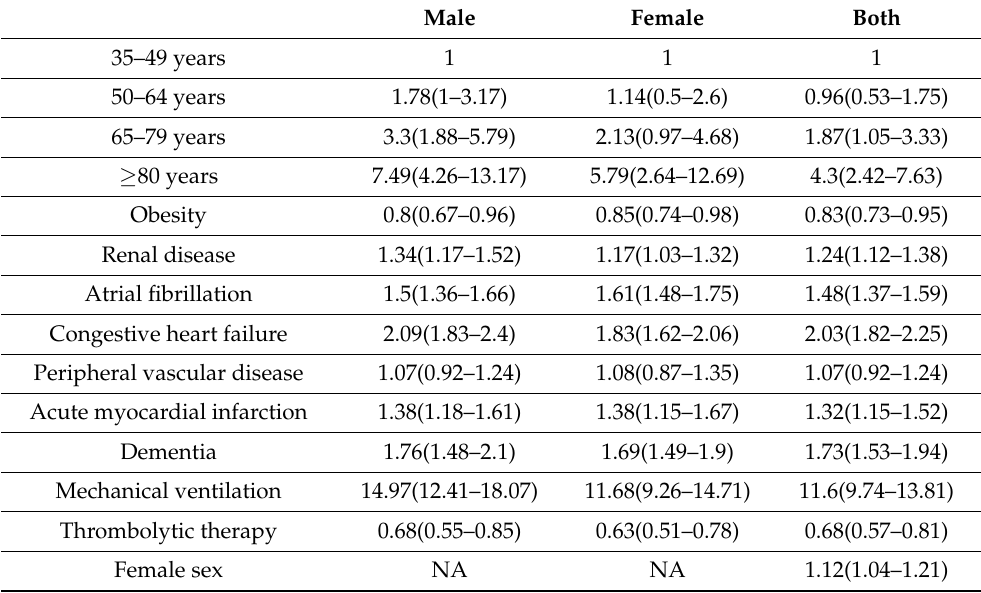
Table 5. Multivariable logistic regression analysis of factors associated with in-hospital mortality among patients with T2DM according to